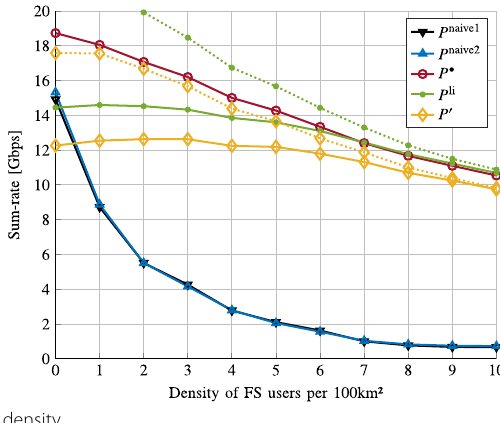
Fig. 5 Sum-rate vs. FS